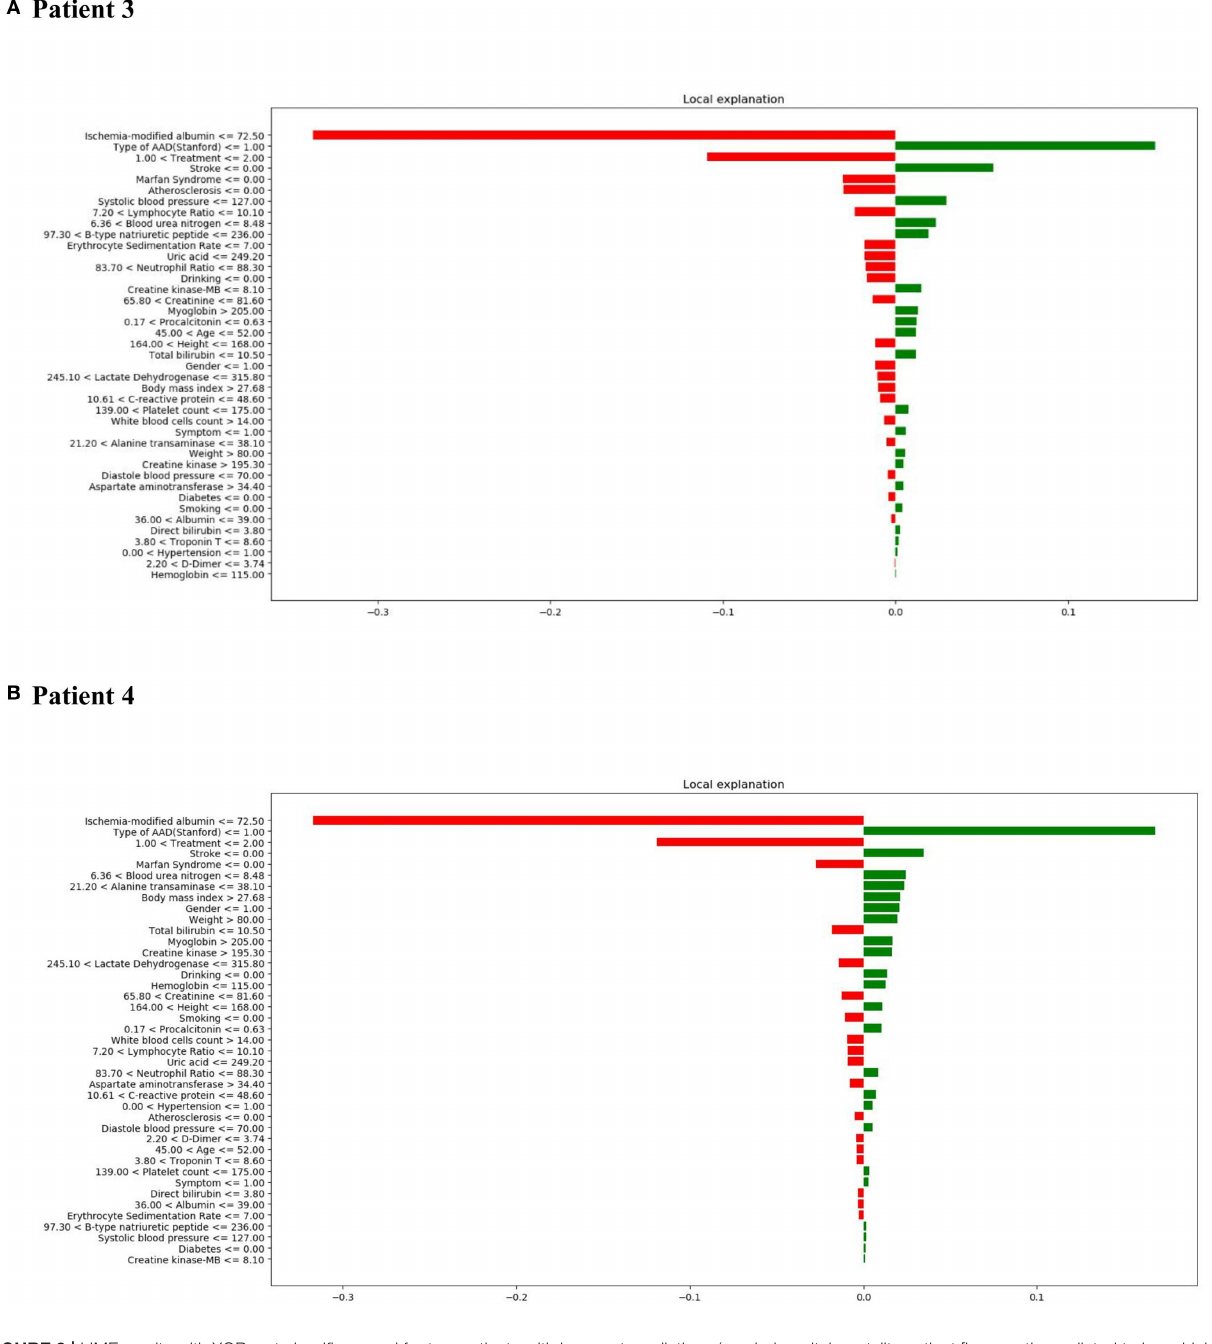
FIGURE 8 | LIME results with XGBoost classifiers used for two patients with incorrect predictions (one in-hospital mortality patient [incorrectly predicted to have high probability of survival] and one survival patient [incorrectly predicted to have a high probability of in-hospital mortality]). (A) LIME explanation for false positive patient 3; (B) LIME explanation for false negative patient